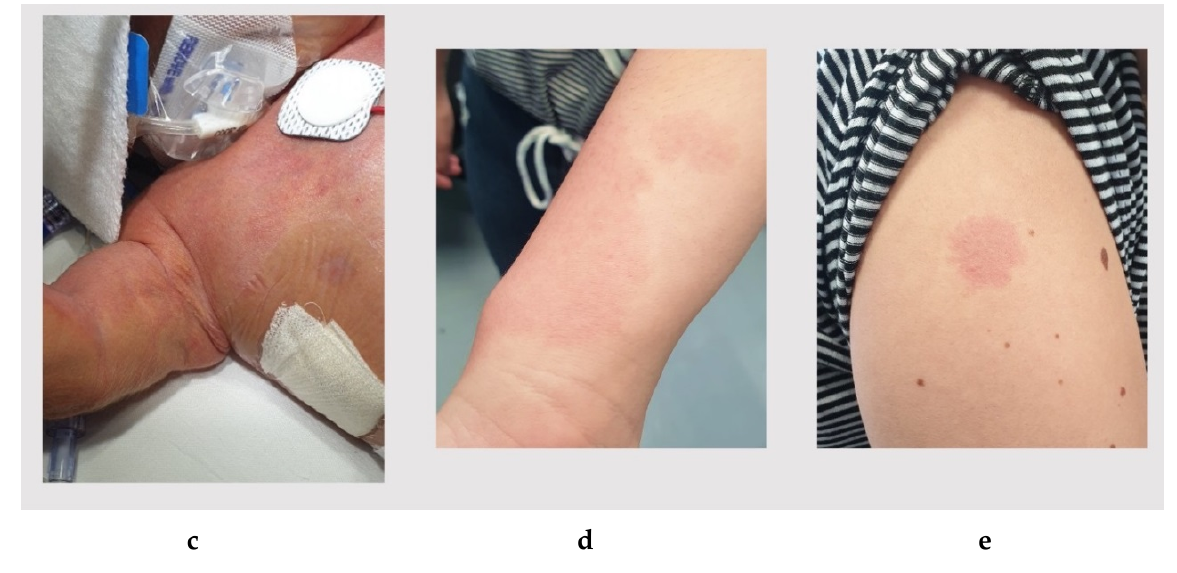
Figure 3. Patient 4: Radiographic images showing destruction and absorption of the proximal epiphysis of the humerus (adjacent to the arteriovenous malformation of the right arm), features indicative of Parkes Weber Syndrome (( a ) at birth and ( b ) at 2 months of life). Proband at birth with overgrown and swollen right limb with skin port-wine stains and subcutaneous pulsatile vascular anomalies ( c ); proband’s mother capillary malformations on her wrist and shoulder ( d , e